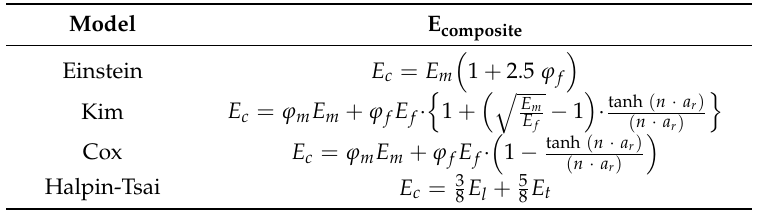
Table 3. List of the analytical expressions used in this work for the prediction of the composites’ Young’s